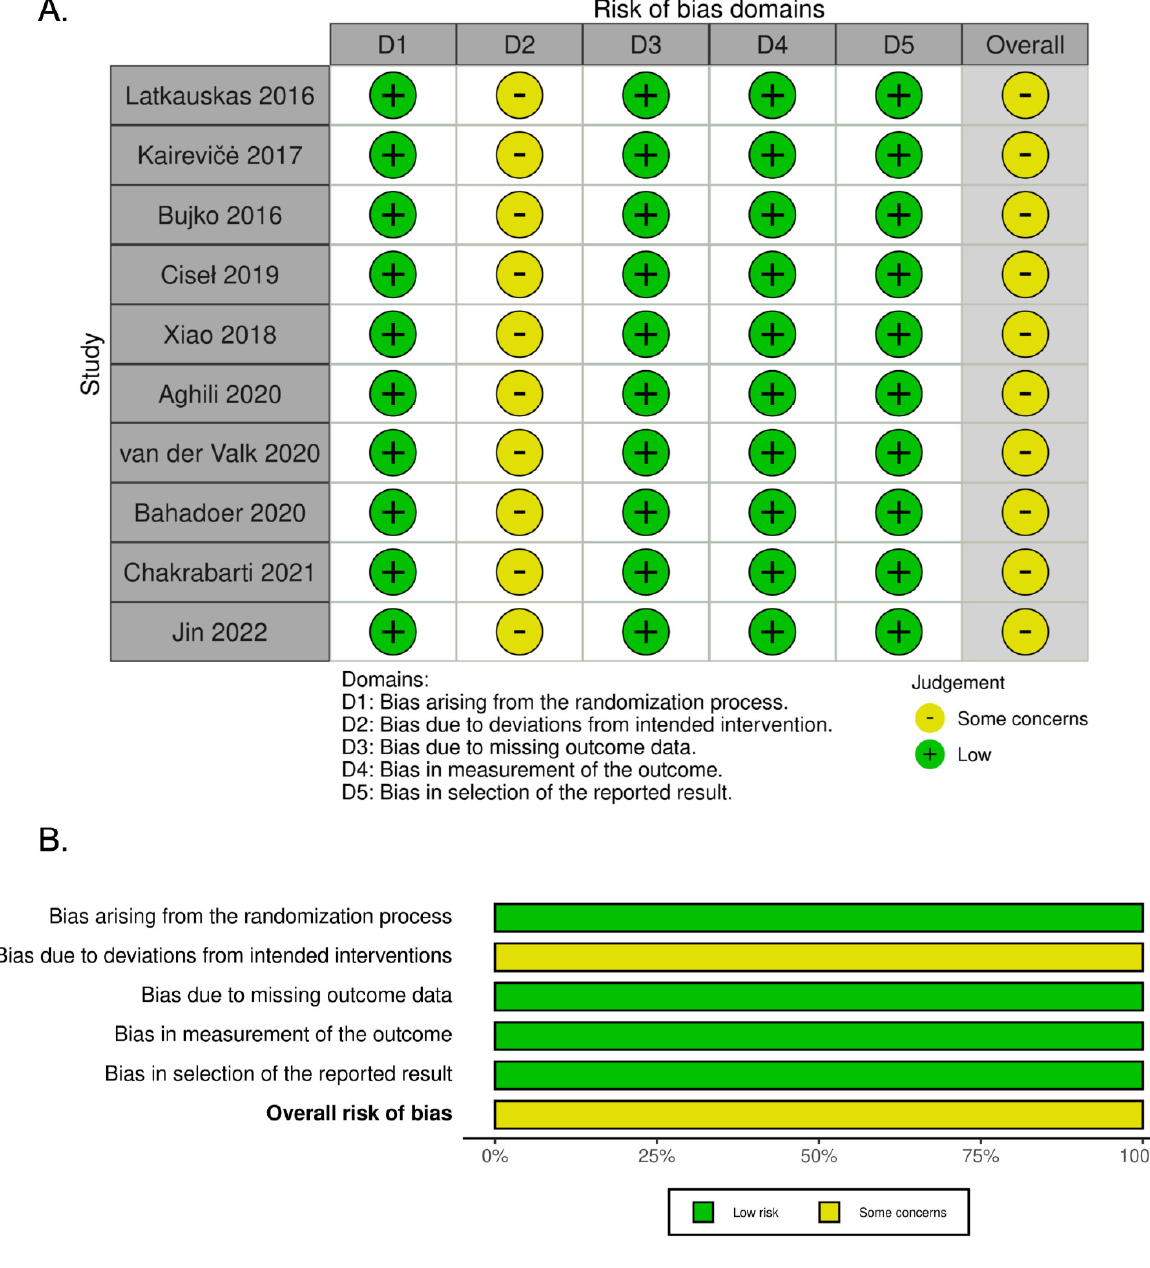
Figure 2. Risk of bias ( A ) assessment and ( B ) summary of the RCTs.